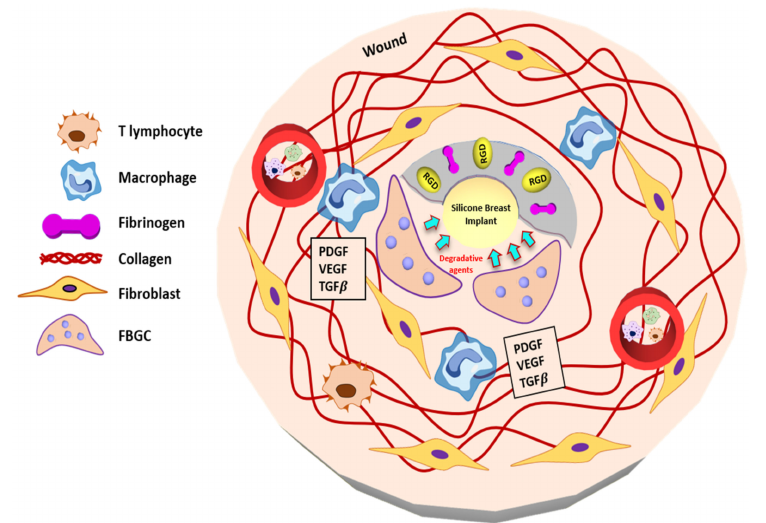
Figure 4. Schematic illustration of Phase 4 after implantation. Foreign body reaction eventually leads to the formation of the fibrous capsule. Various cytokines secreted were responsible for fibrous capsule density as well as severity. Synthesis of collagen, ECM synthesis around the silicone implants at the end of this stage. Reproduced with permission from